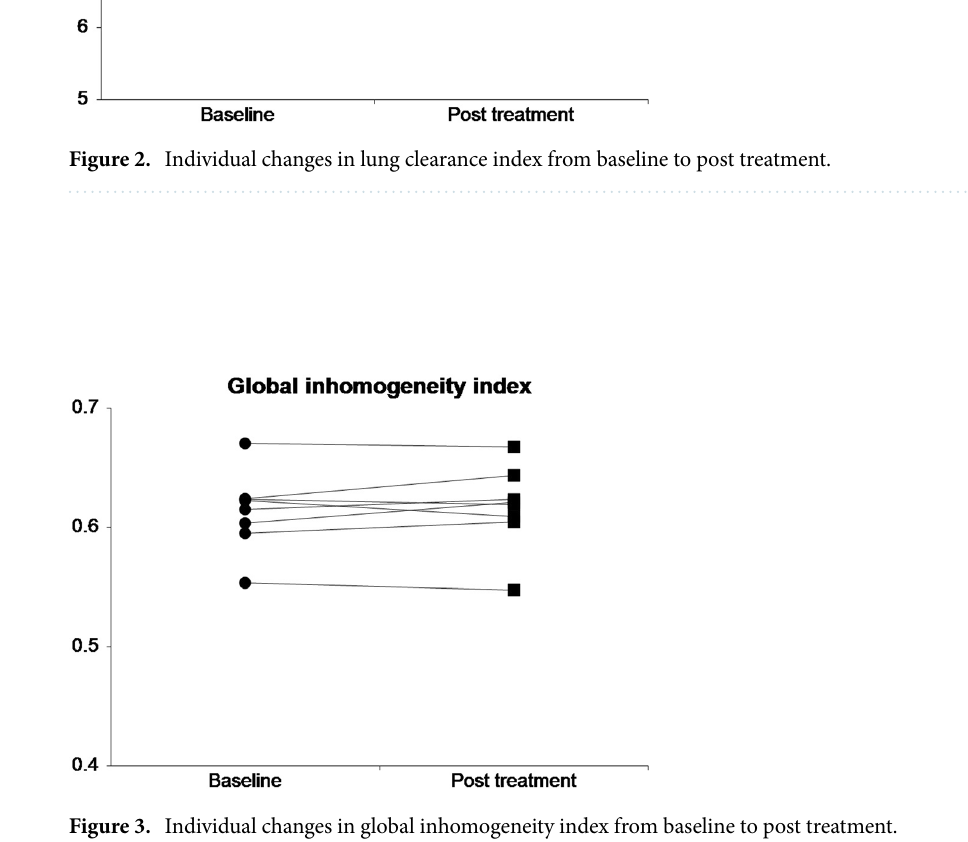
Figure 3. Individual changes in global inhomogeneity index from baseline to post